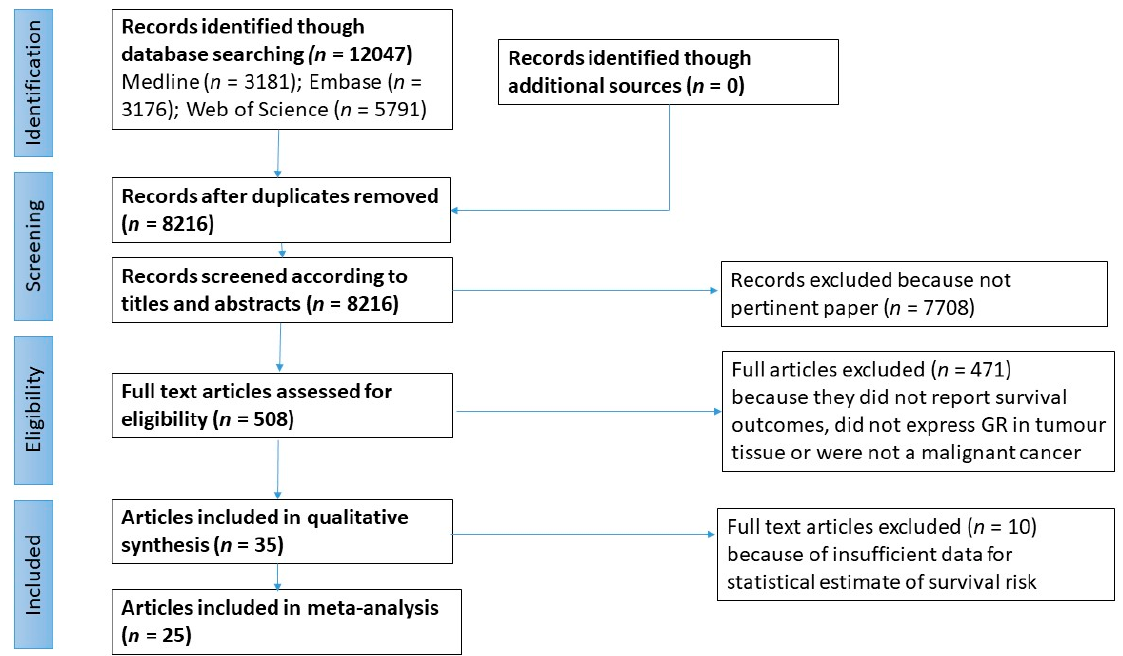
Figure 1. Flow chart of study selection.